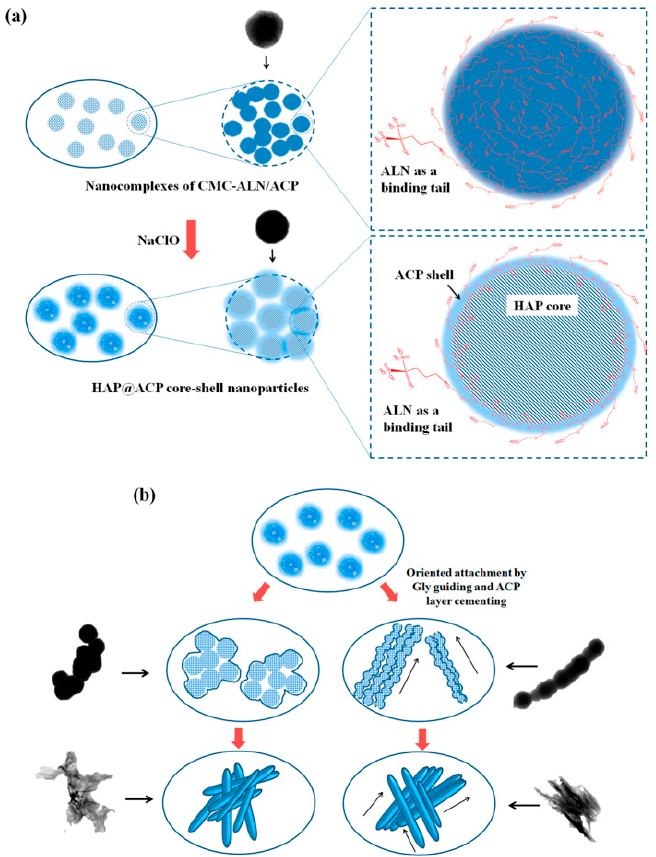
Figure 5. A schematic model of the formation of the nanocomplexes of carboxymethyl chitosan (CMC) conjugated with ALN. ( a ) Nalco hydrolyzes CMC to promote the conversion of ACP to HAP to form HAP@ACP core-shell nanoparticles; ( b ) Glycine-guided HAP@ACP core-shell nanoparticles’ linear aggregation. Reprinted with permission from ref. [98]. Copyright 2021 Springer Nature.